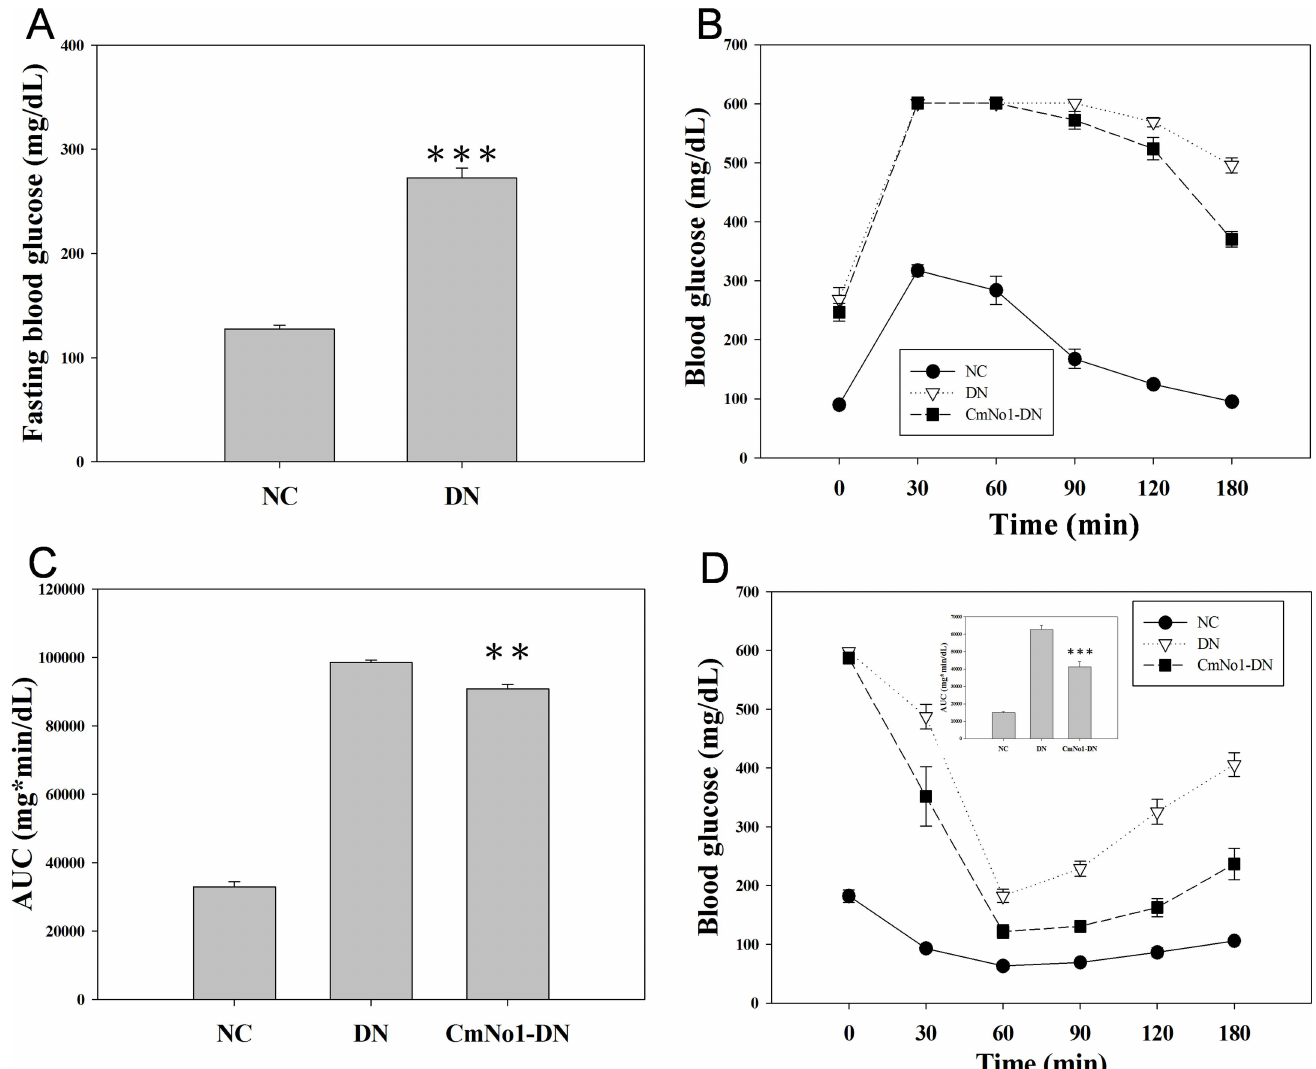
Fig 1. Effect of CmNo1 on glucose and insulin tolerance. (A) Fasting bloodglucose (B) Assessment of glucosetoleranceby oral glucose tolerance test (OGTT) from 0–180 min post-glucose loadingduring8-week CmNo1 treatment (C) Total area under curves (AUC) for OGTT (D) Blood glucose values during intra-peritoneal insulintolerancetest over a periodof 0–180 min during 8-week CmNo1 treatment. Data are expressedas mean ± SEM (NC, n = 5; DN, n = 6; CmNo1-DN,n = 6). Symbols specify significantdifference from DN with ** and *** indicate p < 0.01 and p < 0.001, respectively. The solid circle and open inverted triangledenotesNC and DN respectively while solid square indicateCmNo1-DNmice. NC: Normal control; DN: Diabeticnephropathy; CmNo1-DN:Diabeticnephropathygroup mice treated with Cordycepsmilitaris No1.